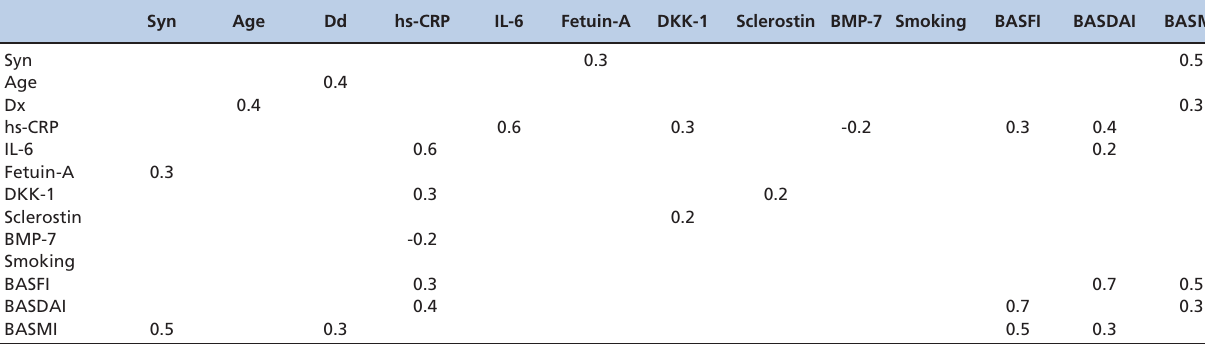
Table 3 - Correlation coefficients of the clinical and laboratory data.